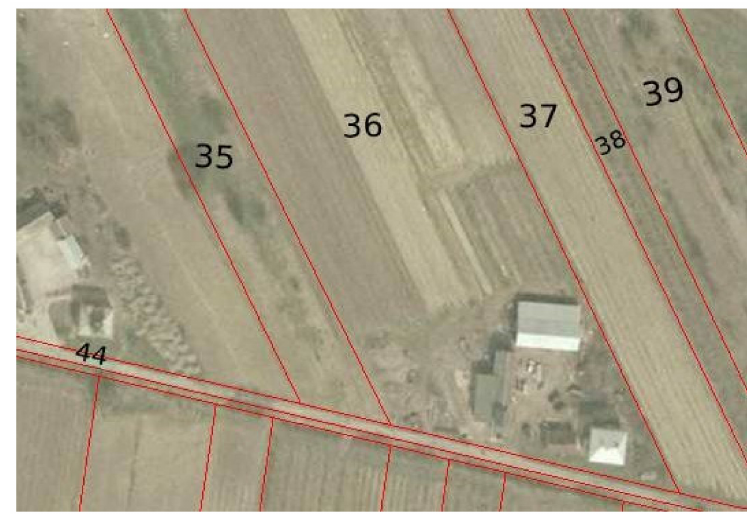
Figure 3. Plan of plots for hop cultivation at farm C (plots 36, 37, 38).